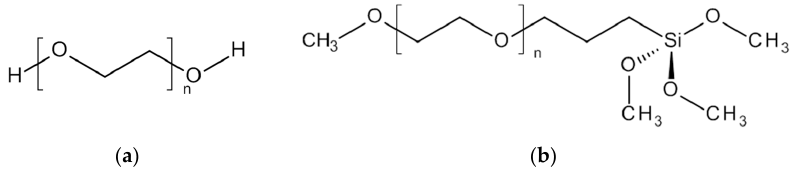
Figure 1. PEG 400 with n ≈ 8.5 and PEG 1000 with n ≈ 22 ( a ); PEG-silane with n ≈ 7.5 ( b ).